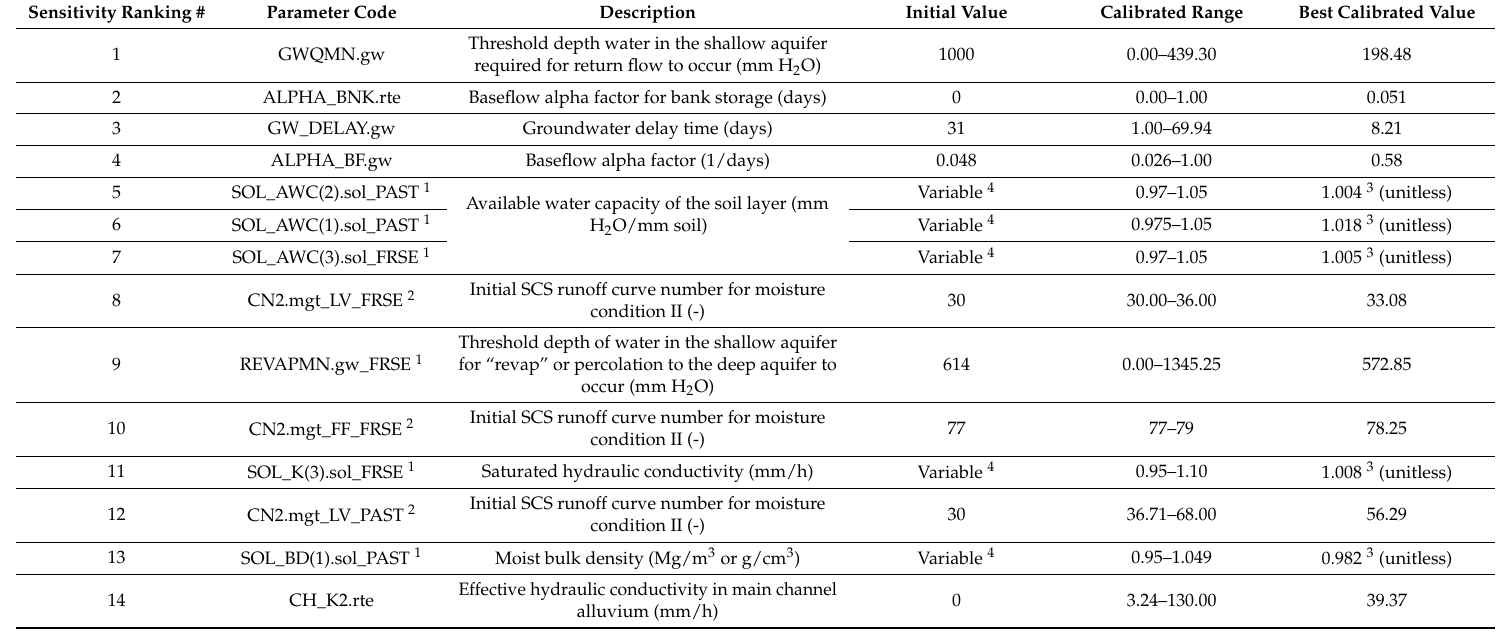
Table 2. Most sensitive parameters included in the automatic calibration, and their initial and calibrated values.